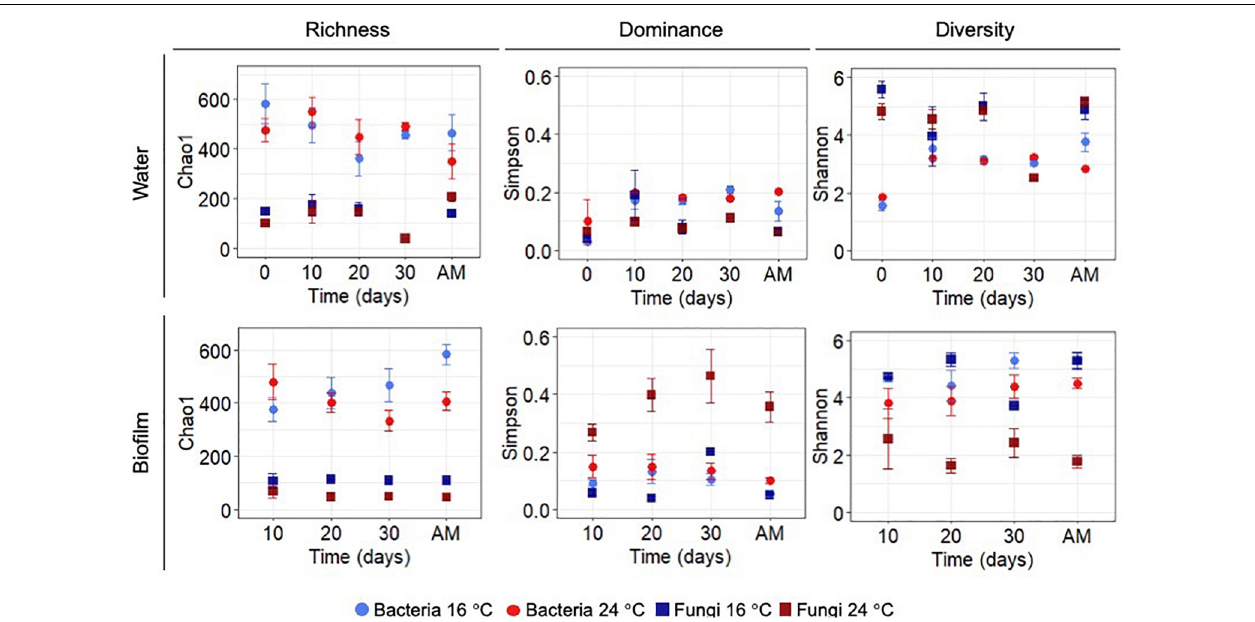
FIGURE 2 | Chao 1 (richness), Simpson (dominance) and Shannon (diversity) indices for OTUs at 97% cut-off for bacteria and fungi in biofilm and water samples calculated for each sampling day during the growth phase and after mobilisation phase (AM). All values represent an average of three water replicates ± standard